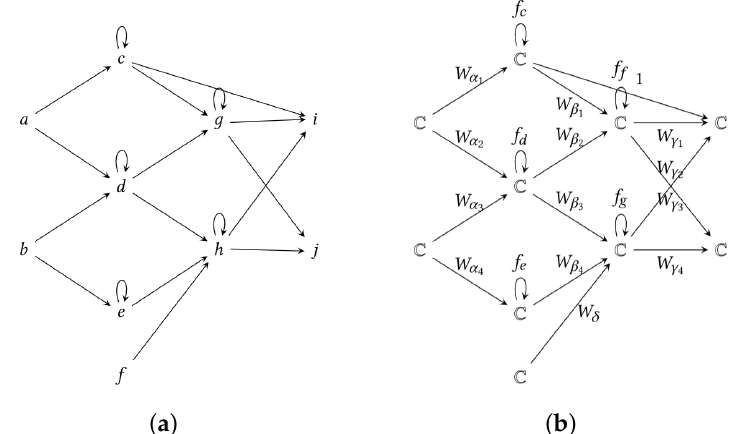
Figure 3. ( a ) A network quiver Q whose input layer is given by the vertices a and b , the vertex f is a bias vertex and there is a skip connection from vertex c to vertex i . Note that we did not label the edges to lighten the diagram. ( b ) A neural network over Q where W α given by multiplication with a number, and the functions f = ( f c , f d , f e , f f , f g ) are the activation functions (could be sigmoid, tanh, ReLU, ELU,